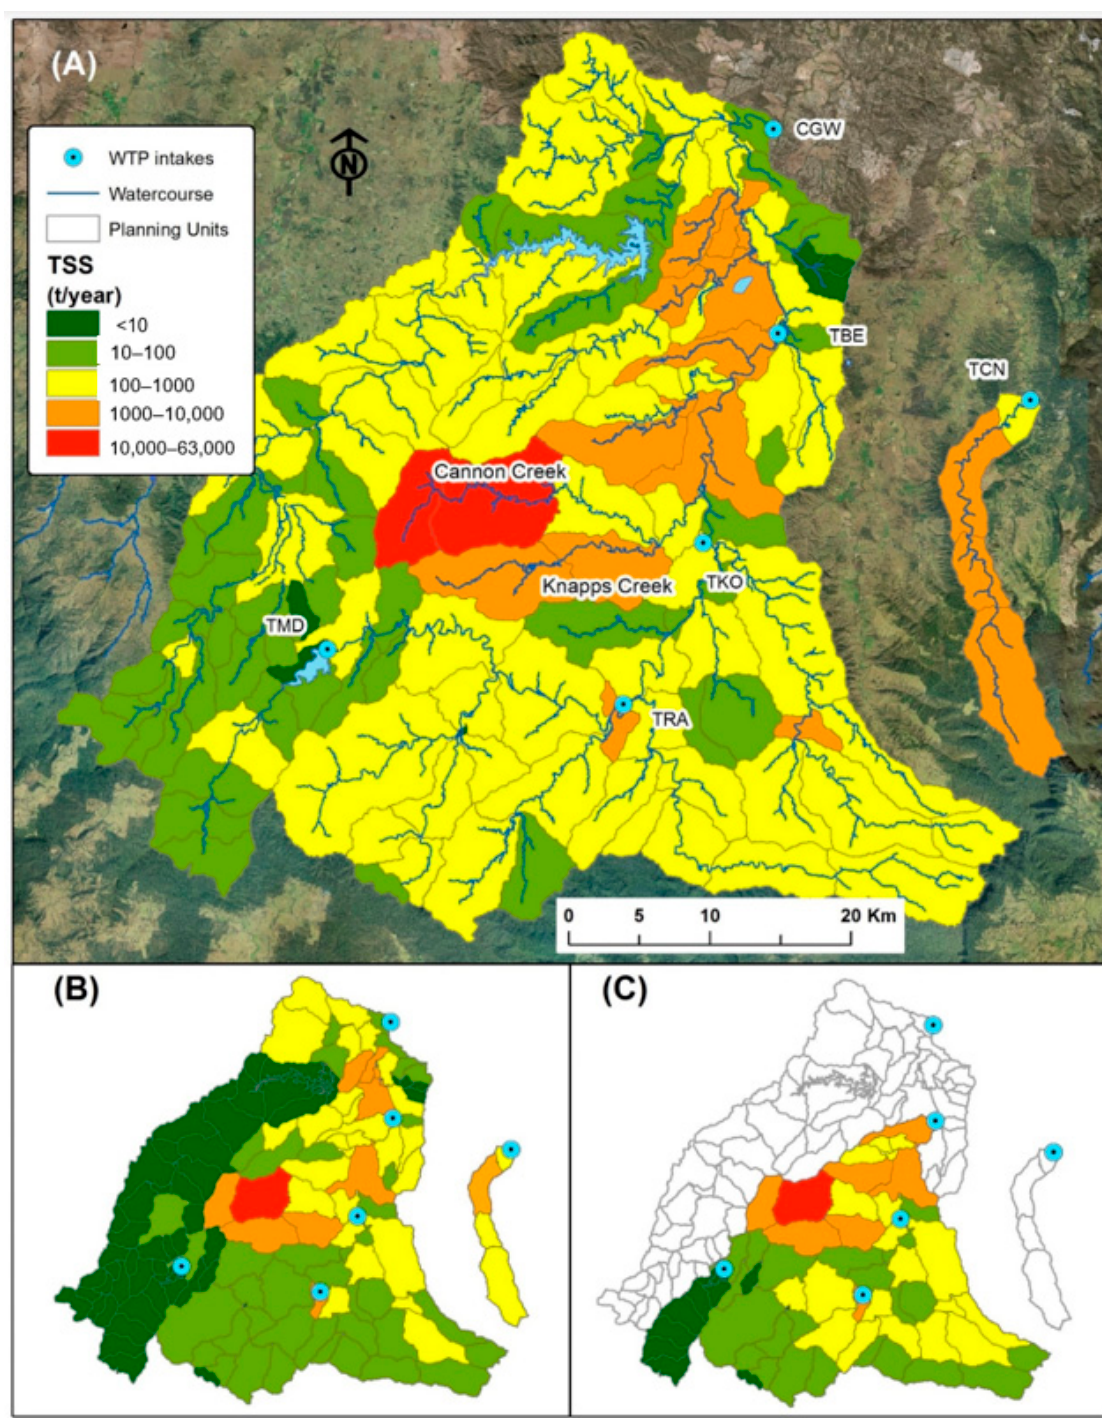
Figure 2. ( A ) Summed total suspended sediments (TSS) loads derived from all hazardous or erosion processes within each planning unit, ( B ) planning unit TSS loads delivered (less deposition/storage) to the proposed CGW and TCN water treatment plants, and ( C ) comparison with TSS loads delivered to the nested TBE, which has shorter transport distances and therefore less TSS deposition between planning units and the WTP. Cannon and Knapps Creeks are shown to highlight tributaries subject to previous studies due to high rates of erosion. See Table 1 for WTP names.